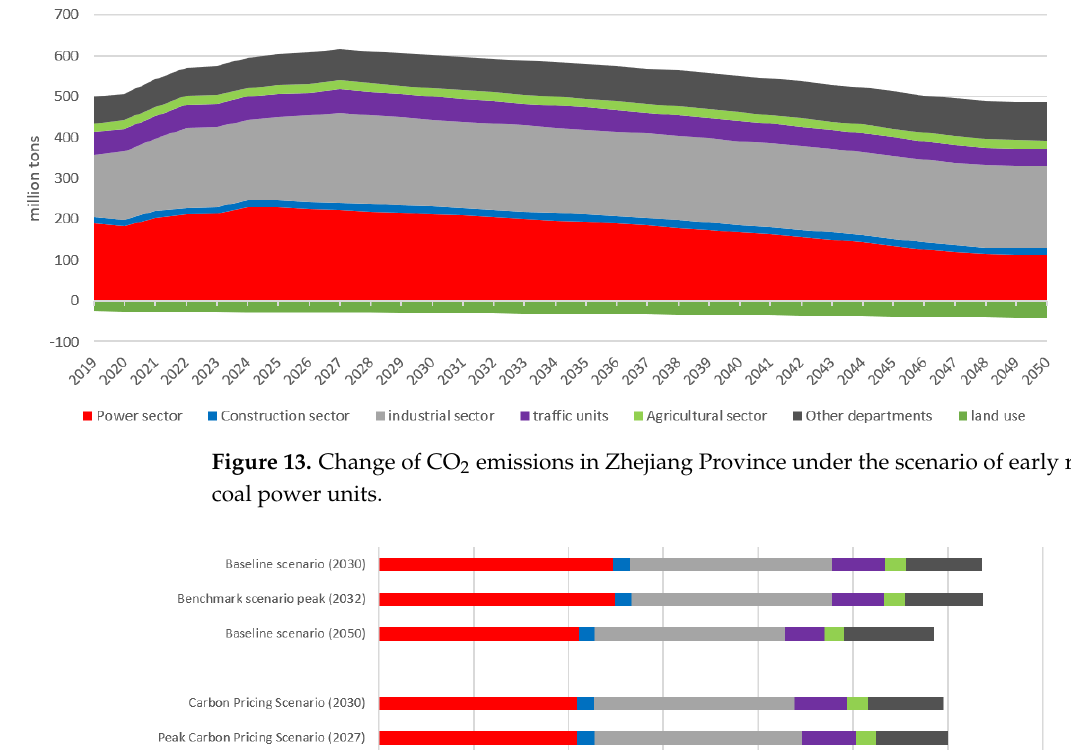
Figure 13. Change of CO 2 emissions in Zhejiang Province under the scenario of early retirement of coal power units.